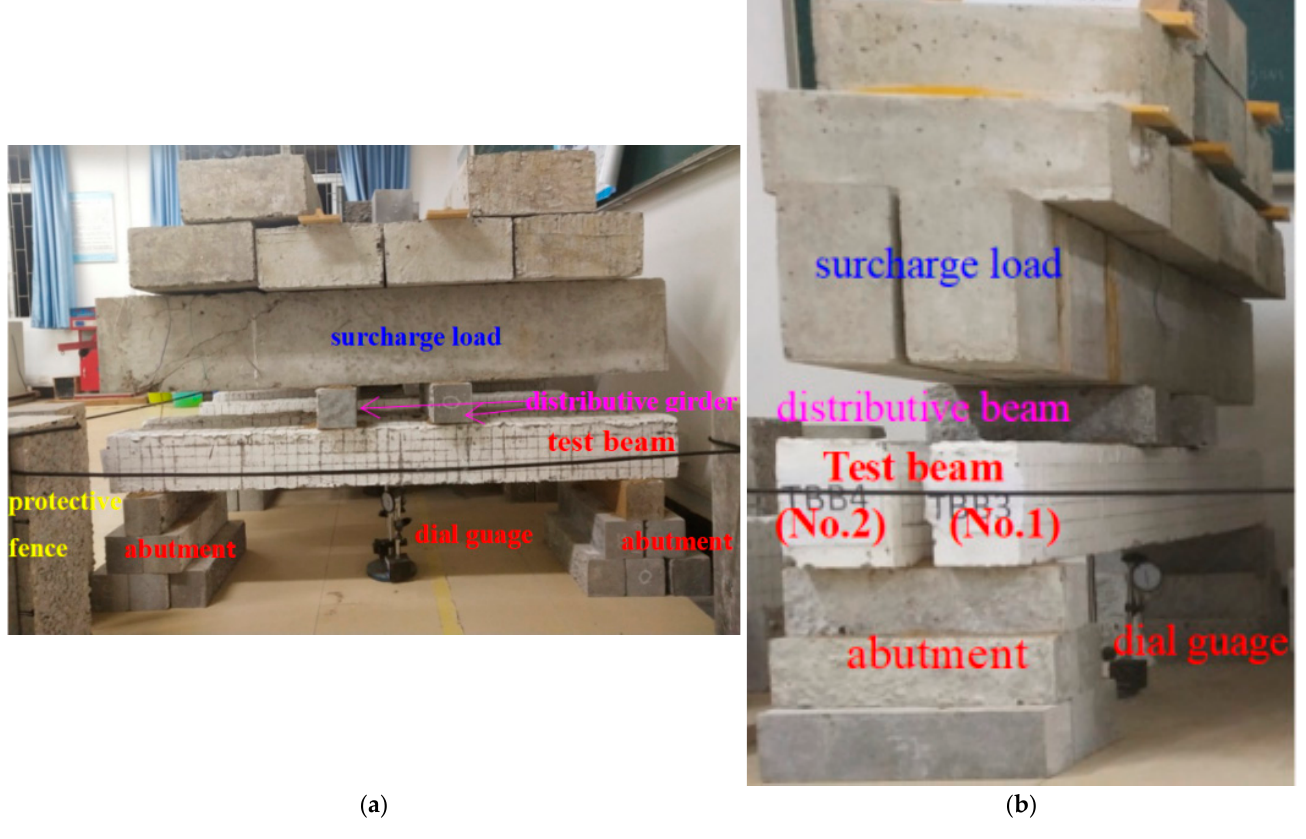
Figure 3. Snapshots of loading. ( a ) Front view. ( b ) Side view.